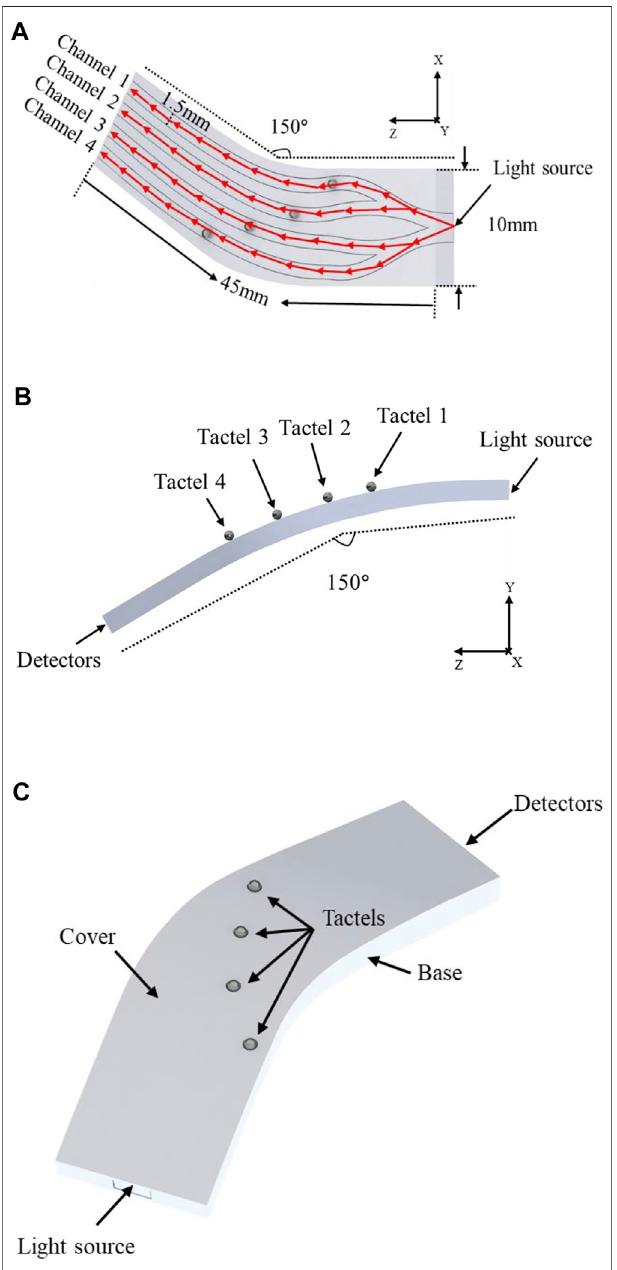
FIGURE 2 | The layout of the proposed multi-point sensor. (A) The opticalpathofthewaveguide, (B) thediameterofbendingandthepositionsof tactels on the 3D surface, (C) Encapsulated